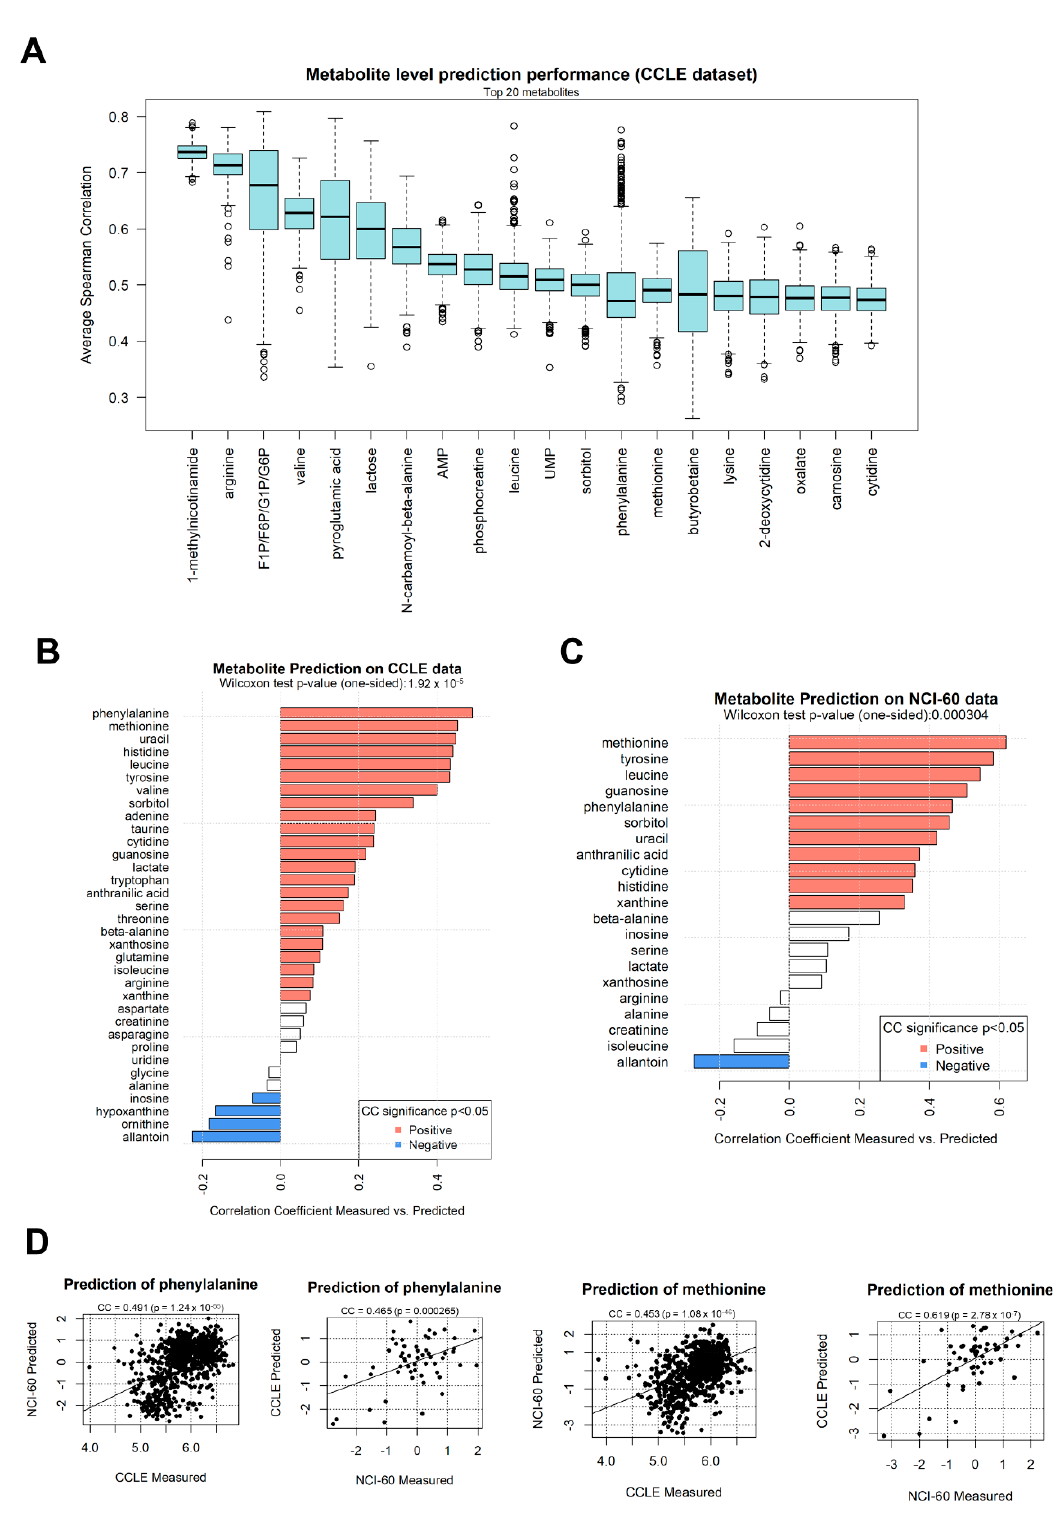
Figure 3. ( A ) Correlation coefficient distribution between predicted and measured metabolite levels within the CCLE dataset, using 2000 training/test splits each taking separate halves of the full dataset. This panel shows the 20 polar metabolites with higher correlation coefficients and can effectively be considered as a labeled section of Figure 2C; ( B ) correlation coefficients calculated between predicted and experimentally measured metabolite levels in the CCLE dataset, using a network model extracted from the NCI-60 dataset. Bars are colored in red if the correlation coefficient is significant ( p < 0.05) and positive, in blue if significant and negative, in white otherwise; ( C ) corre- lation coefficients calculated between predicted and experimentally measured metabolite levels in the NCI-60 dataset, using a network model extracted from the CCLE dataset; ( D ) scatter plots